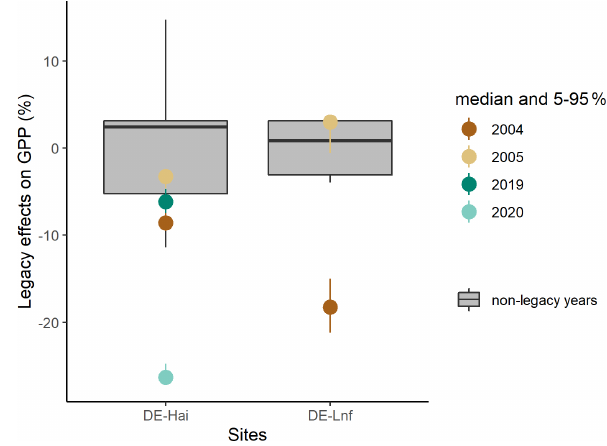
Figure 4. Integrated residuals of GPP anomalies at the annual scale in legacy years at DE-Hai and DE-Lnf. The coloured points and line ranges show the median and 5%–95% percentile integrated GPP anom residuals of the ensemble model runs (see Sect. 3.4), re- spectively. The model uncertainties (the box plot) are characterised as the 25th–75th quantile range of integrated GPP anom residuals in non-legacy